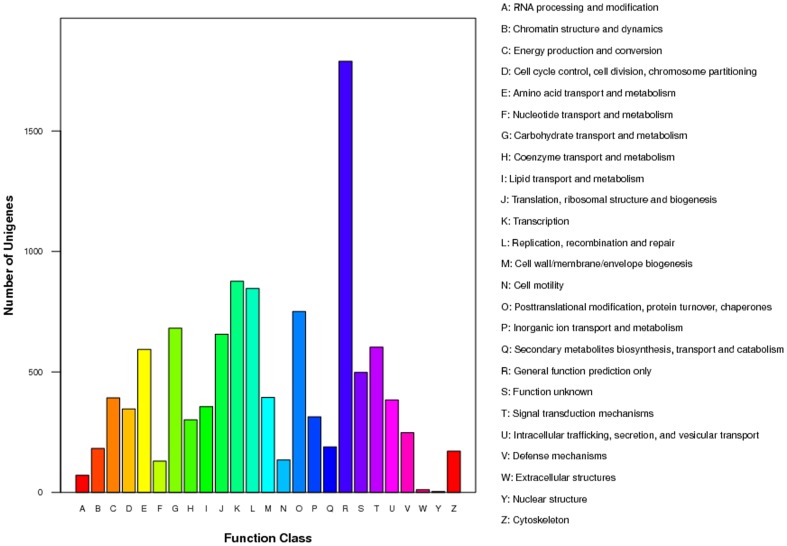
COG function classification of all unigenes from transcriptome of P.splendens.A, RNA processing and modification; B, Chromatin structure and dynamics; C, Energy production and conversion; D, Cell cycle control, cell division, chromosome partitioning; E, Amino acid transport and metabolism; F, Nucleotide transport and metabolism; G, Carbohydrate transport and metabolism; H, Coenzyme transport and metabolism; I, Lipid transport and metabolism; J, Translation, ribosomal structure and biogenesis; K, Transcription; L, Replication, recombination and repair; M, Cell wall/membrane/envelope biogenesis; N, Cell motility; O, Posttranslational modification, protein turnover, chaperones; P, Inorganic ion transport and metabolism; Q, Secondary metabolites biosynthesis, transport and catabolism; R, General function prediction only; S, Function unknown; T, Signal transduction mechanisms; U, Intracellular trafficking, secretion, and vesicular transport; V, Defense mechanisms; W, Extracellular structures; Y, Nuclear structure; Z, Cytoskeleton.